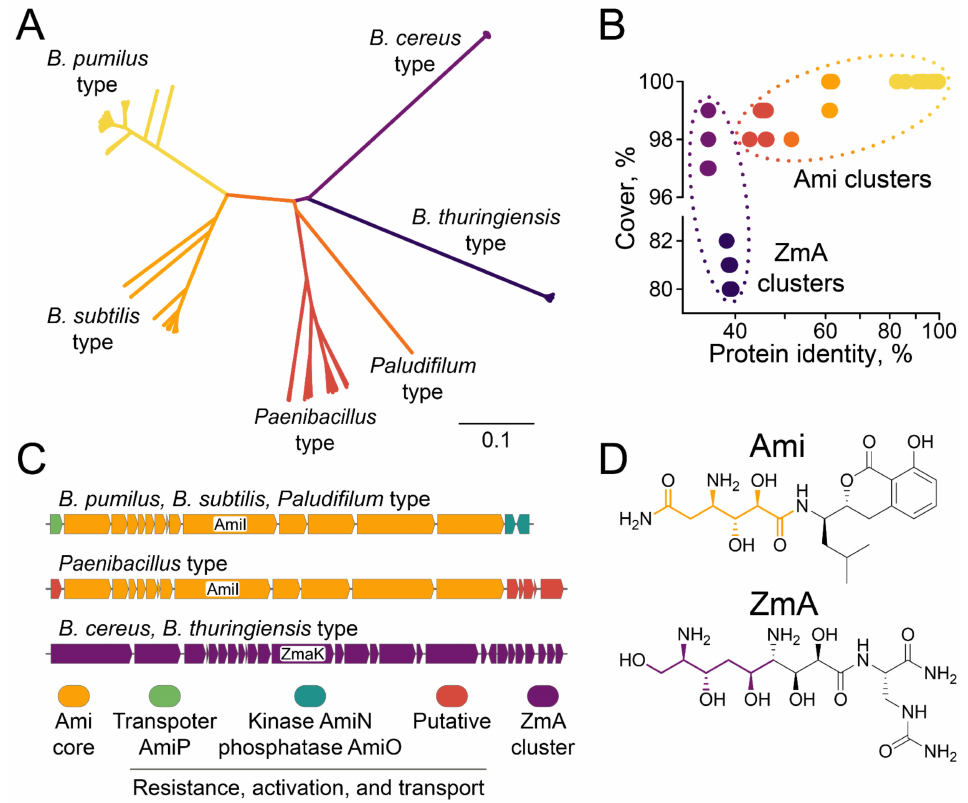
Figure 5. Biodiversity of Ami clusters. ( A ) A phylogenetic tree of Ami clusters was built based on the key hybrid PKS/NRPS enzyme AmiI homology. BGCs encoding Ami ( B. pumilus type, B. subtilis type, Paludifilum type, and Paenibacillus type) are colored with warm colors (yellow, orange, and red). BGCs encoding zwittermicin A (ZmA) are colored with cold colors (sapphire and violet for B. thuringiensis type and B. cereus type, respectively). ( B ) Protein identity and protein cover of AmiI homologs. Ami cluster family and ZmA cluster family are highlighted with a dotted line. ( C ) Comparative analysis of the architecture of Ami clusters and ZmA clusters and ( D ) their biosynthetic products. Core Ami enzymes are colored with orange. ZmA cluster is colored with violet. AmiI in Ami cluster and its homolog ZmaK in ZmA cluster are subscribed and their biosynthetic fragments are highlighted with orange and violet in Ami and ZmA structures, respectively. Transporter AmiP is colored with green. Kinase AmiN and phosphatase AmiO mediate self-resistance toward Ami and Ami activation, respectively. AmiN and AmiO are colored with aquamarine. Paenibacillus genes encoding proteins putatively associated with transport/self-resistance are colored with